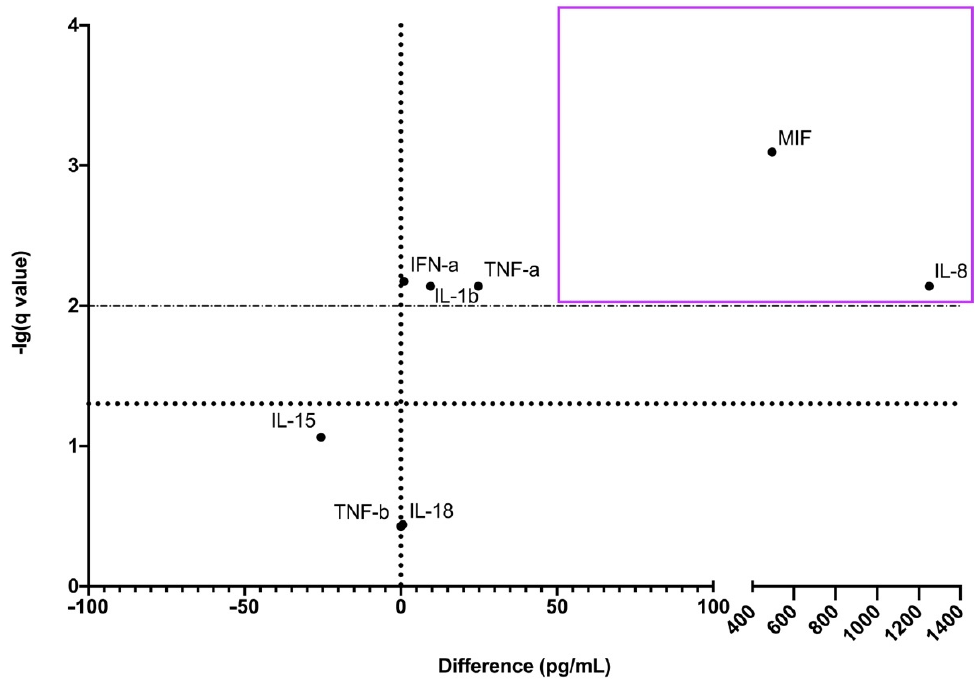
Figure 1. Volcano-plot of CECs’ cytokine production. Purple rectangle contains cytokines that were reliably more produced by adult bone marrow CECs.